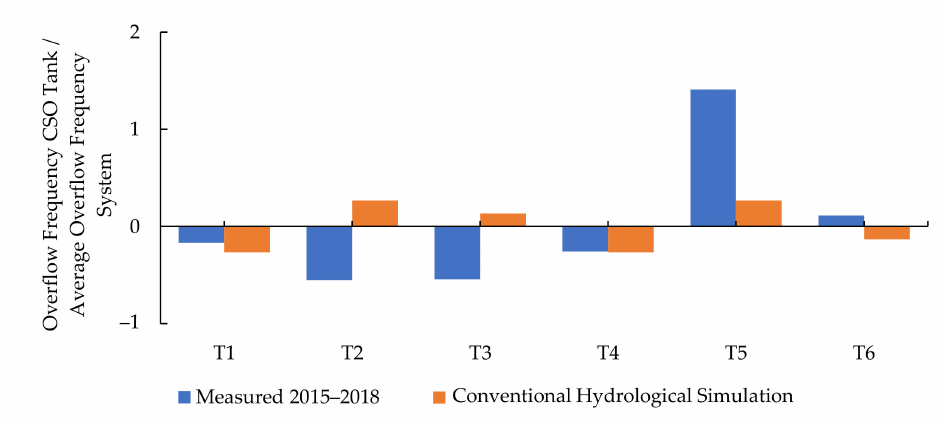
Figure 9. Standardized simulated and measured overflow frequencies for the status